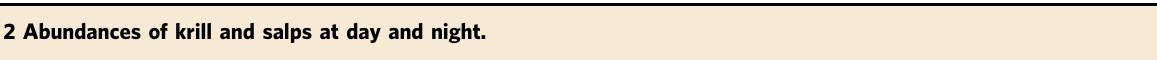
Values are given for each of the respective stations and drifting trap deployments (DF 1 – 5). The mean and standard deviation (SD) is given across all stations for each parameter, respectively.